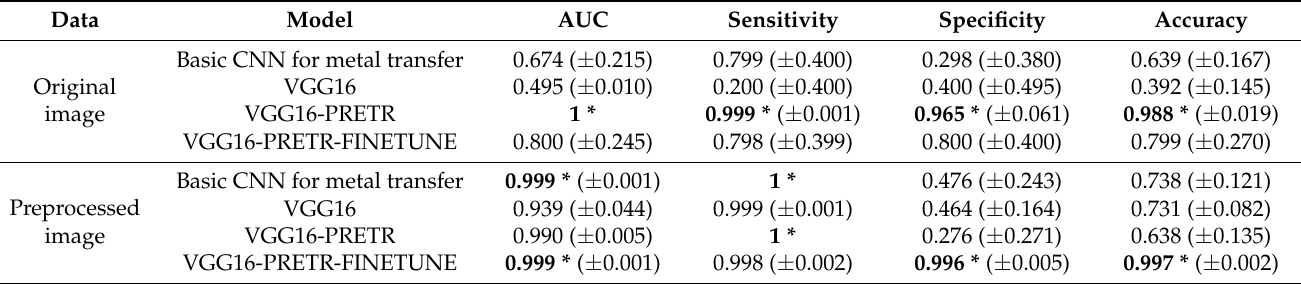
Table 2. Defect detection performance of CNN models for metal transfer